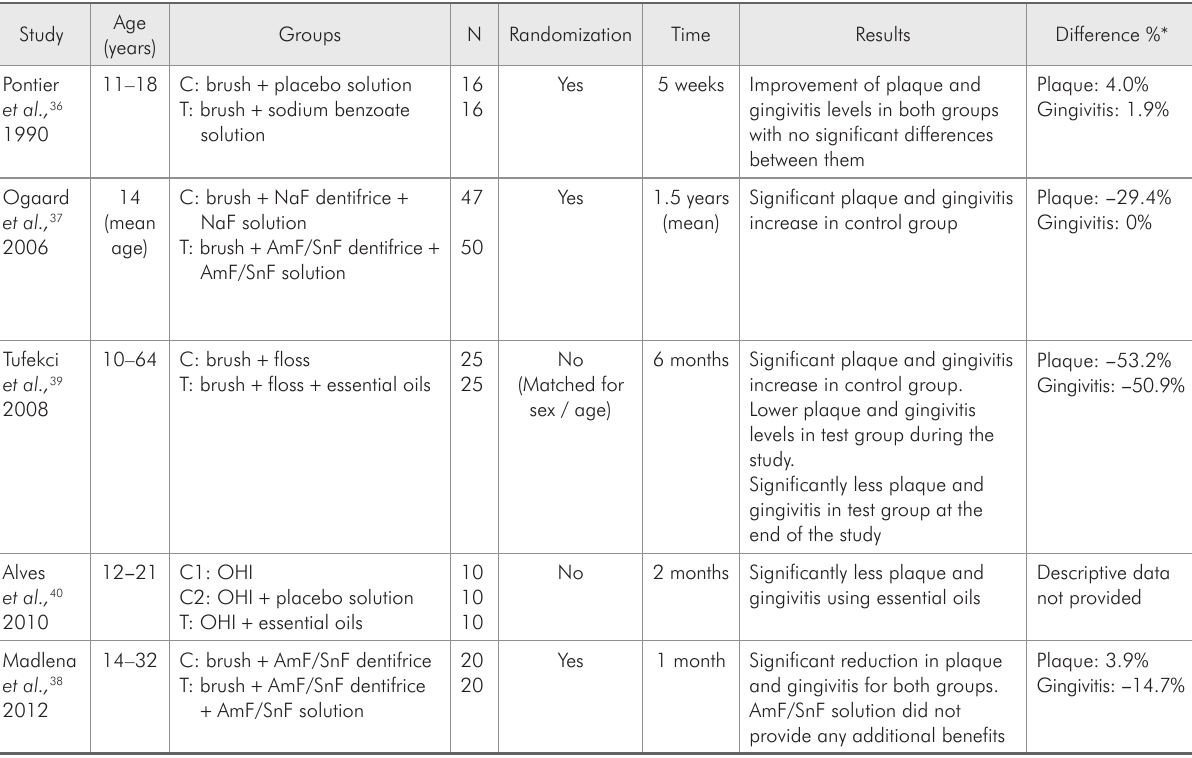
* Difference between test and control groups (negative sign indicates better result for the test group). C: control; T: test; OHI: oral hygiene instruction; AmF/SnF: amino-stannous fluoride, NaF: sodium